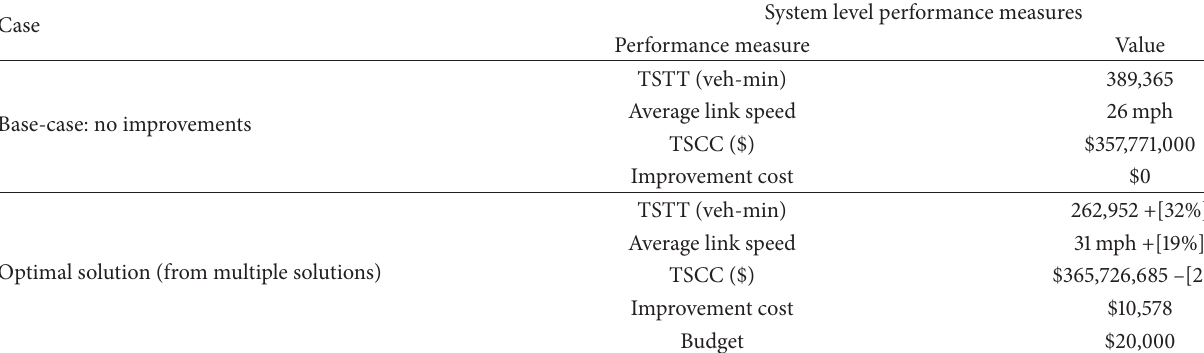
Table 4: Solution for the small city network.